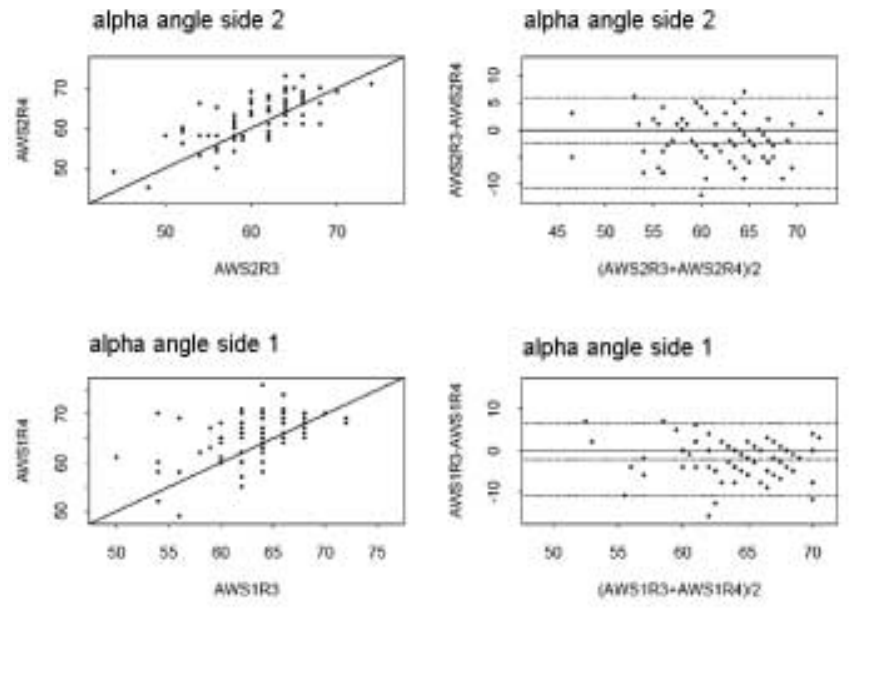
Figure 3 Bland/Altman plots for alpha angles of the paediatrician and the registrar in orthopaedics (side2 disordered), (side1